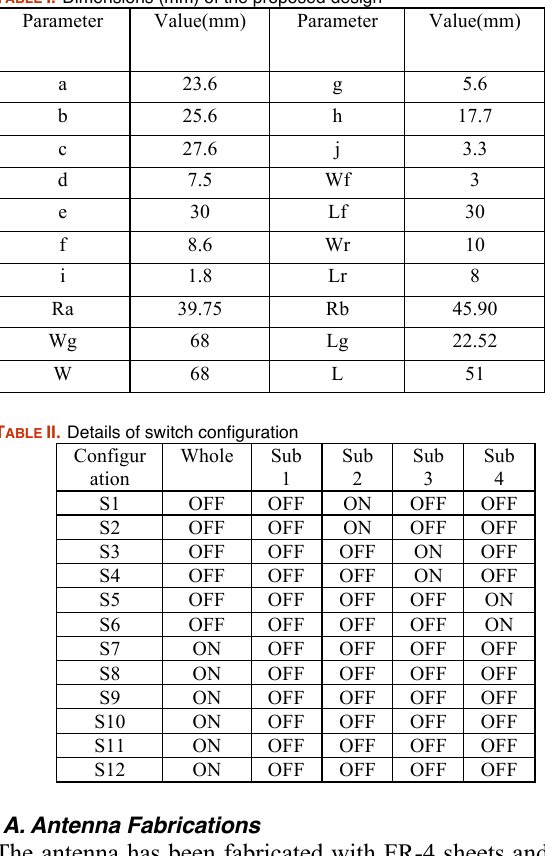
Figure 3. RLC equivalent circuit model of PIN diode a) ON State, b) OFF state